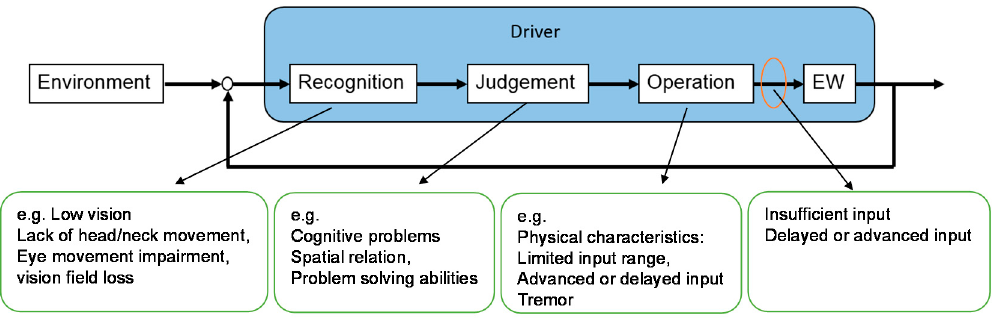
Figure 2. Driver inner model.